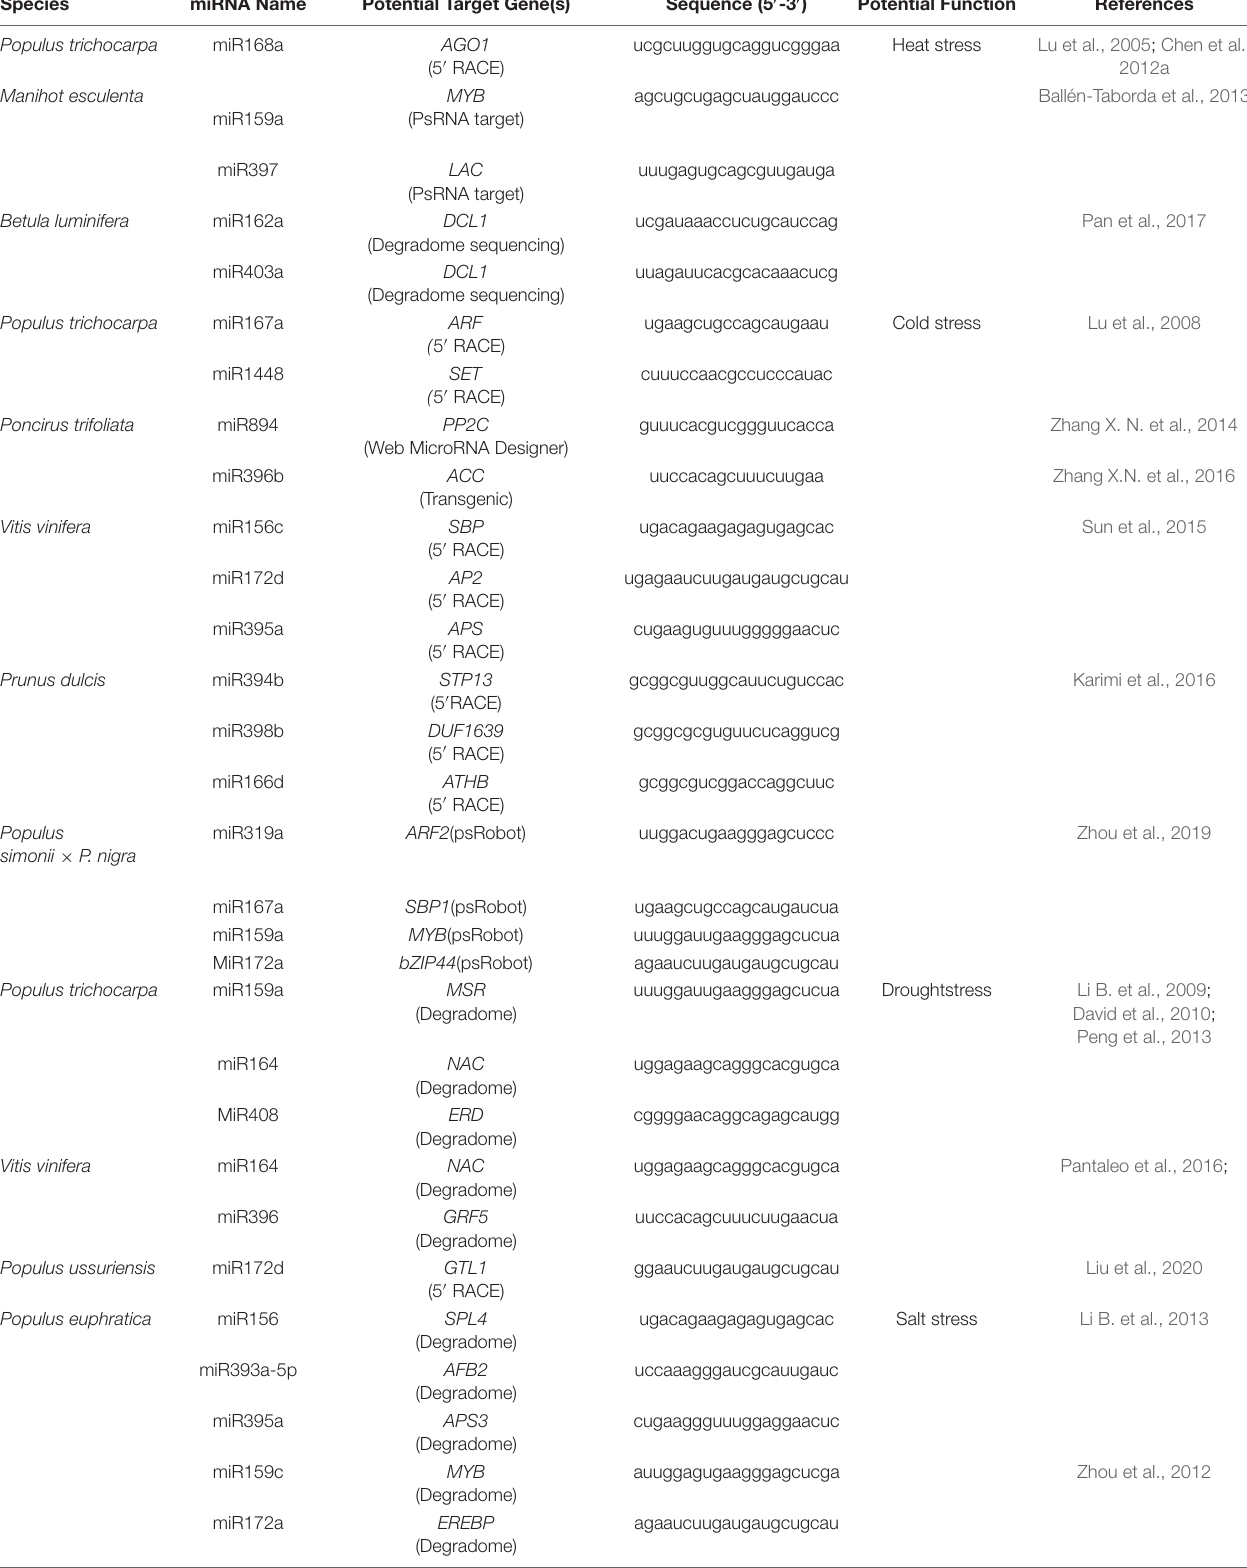
TABLE 3 | MiRNAs are important to the biotic and abiotic stresses of trees.